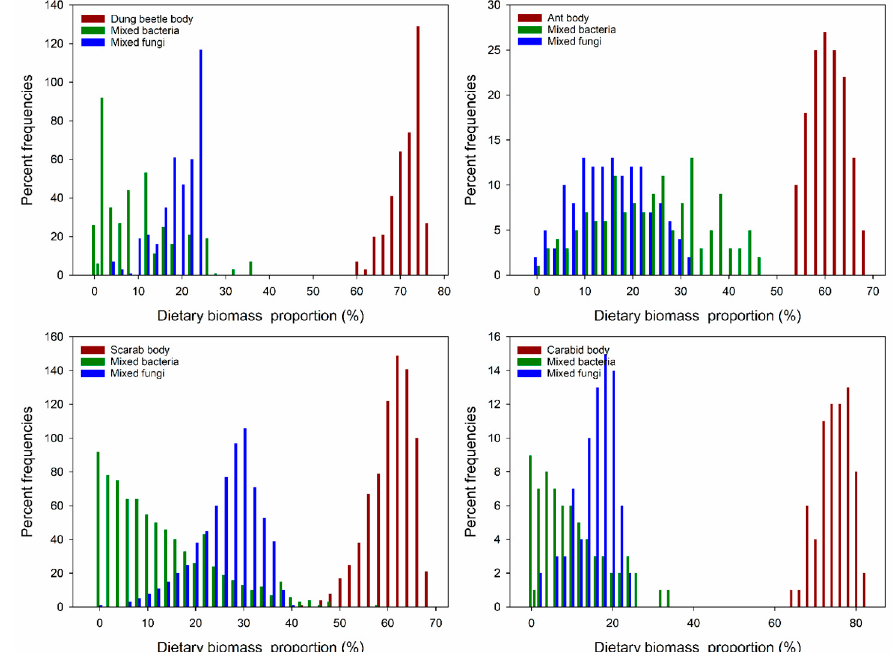
Figure 2. Dietary biomass proportions of the three aggregate food sources for E. proxima . The aggregate solutions are sums of the biomass contributions for the food sources in each category (insects body, mixed bacteria, and mixed fungi). Increments of 2% were used to calculate the aggregate contributions in the model iterations.